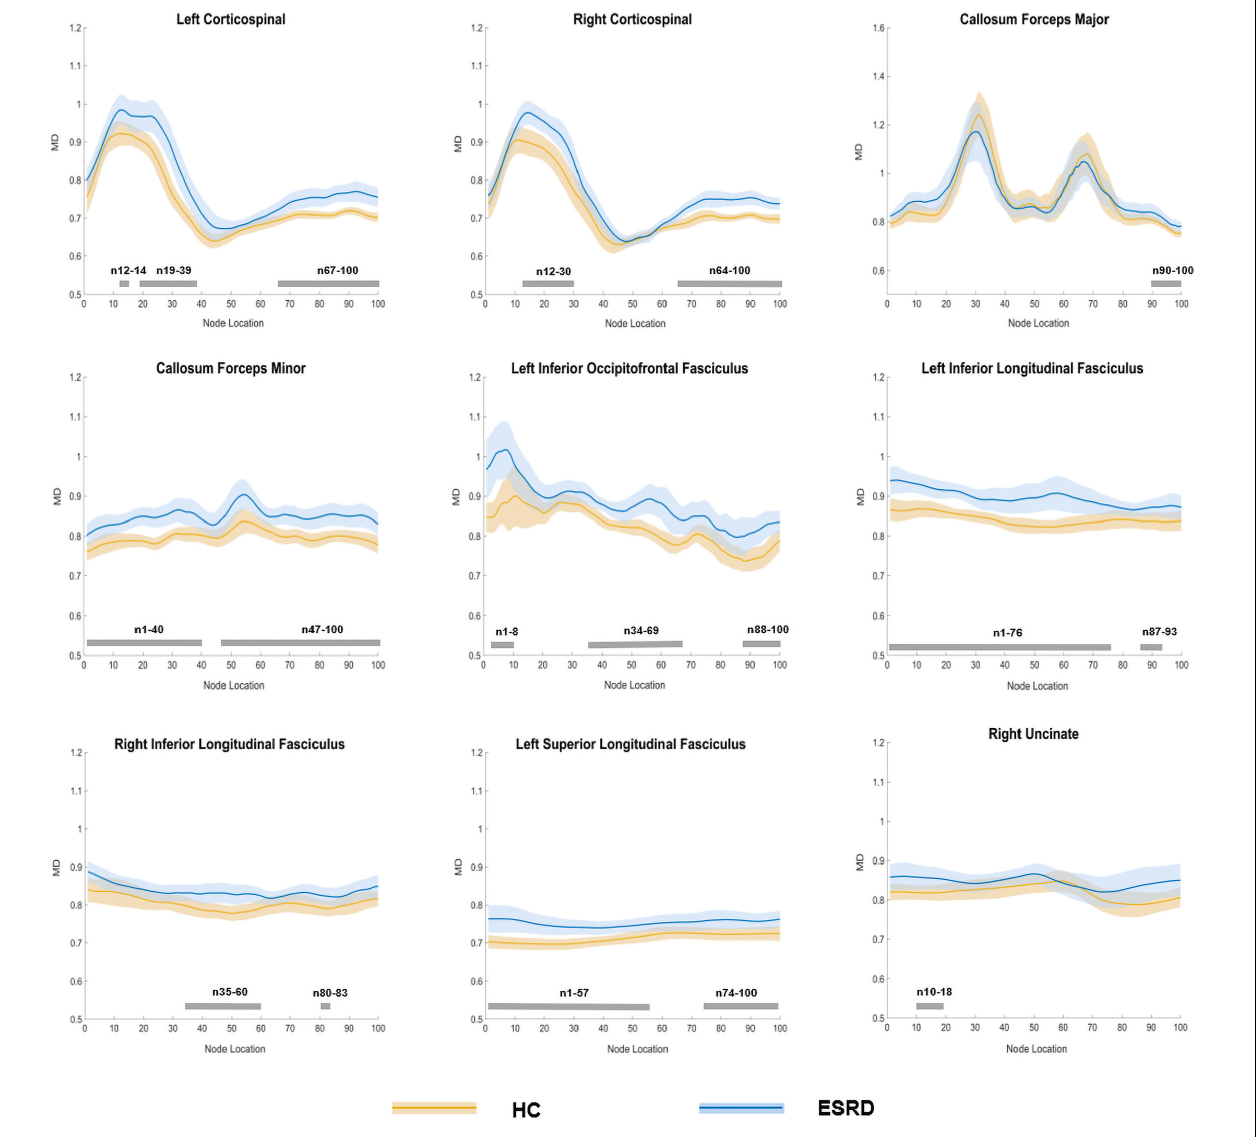
FIGURE 5 | Plots of significantly altered locations in point-wise comparison of MD values between HCs and ESRD ( P < 0.05, FDR correction). The orange line represents the HC group; the blue line represents the ESRD group (solid lines for means and shaded regions for confidence interval). The gray bars at the bottom are the regions of the fiber segment with significant difference between the two groups. ESRD, end stage renal disease; HC, health control; MD, mean